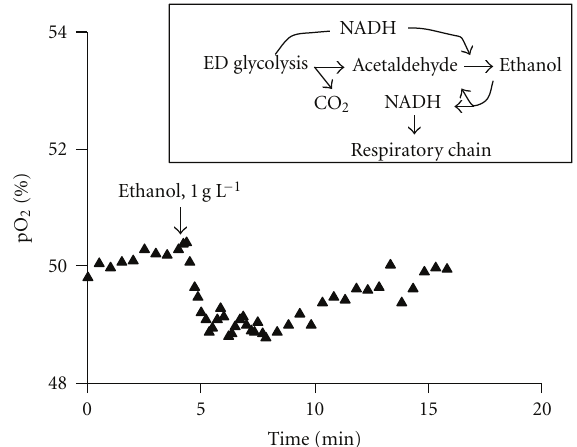
Figure 1: Typical response of aerobic chemostat culture of Zymomonas mobilis Zm6 to ethanol addition. Cultivation param- eters: 1L culture volume, pH 5.5, D 0.2 h − 1 , air flow 2Lmin − 1 , stir- ring rate 500–600 r.p.m. A burst of respiration, seen as a transient decrease of pO 2 in the fermentor, takes place after addition of 1 gL − 1 ethanol. Inset . The proposed scheme of generation and utilization of reducing equivalents in the ethanol cycle—two opposite, rapid ADH reactions, resulting in a slow net aerobic ethanol